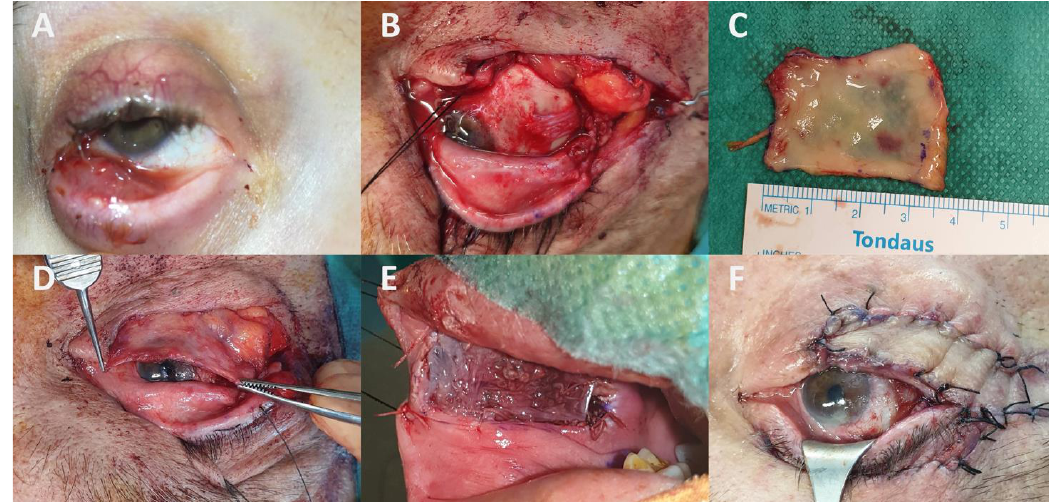
Figure 6. Wide full-thickness removal of a large conjunctival melanoma (CM). ( A ) CM invading the inferior fornix, the inferior bulbar conjunctiva and the inferior tarsal conjunctiva. ( B ) Tumour removal resulted in an 80% full-thickness lower eyelid defect and a 180° inferior bulbar conjunctiva defect; ( C ) A large buccal membrane graft was harvested; ( D ) The buccal membrane graft was positioned and allowed reconstructing the bulbar conjunctiva, the inferior fornix and the posterior lid lamella; ( E ) Direct closure was not possible. The defect was closed with a cryopreserved amniotic membrane graft sutured with interrupted 4/0 absorbable braided sutures + fibrin glue; ( F ) Anterior lamella was reconstructed with a dermatochalasis flap providing vascularization to the underlying oral membrane graft.